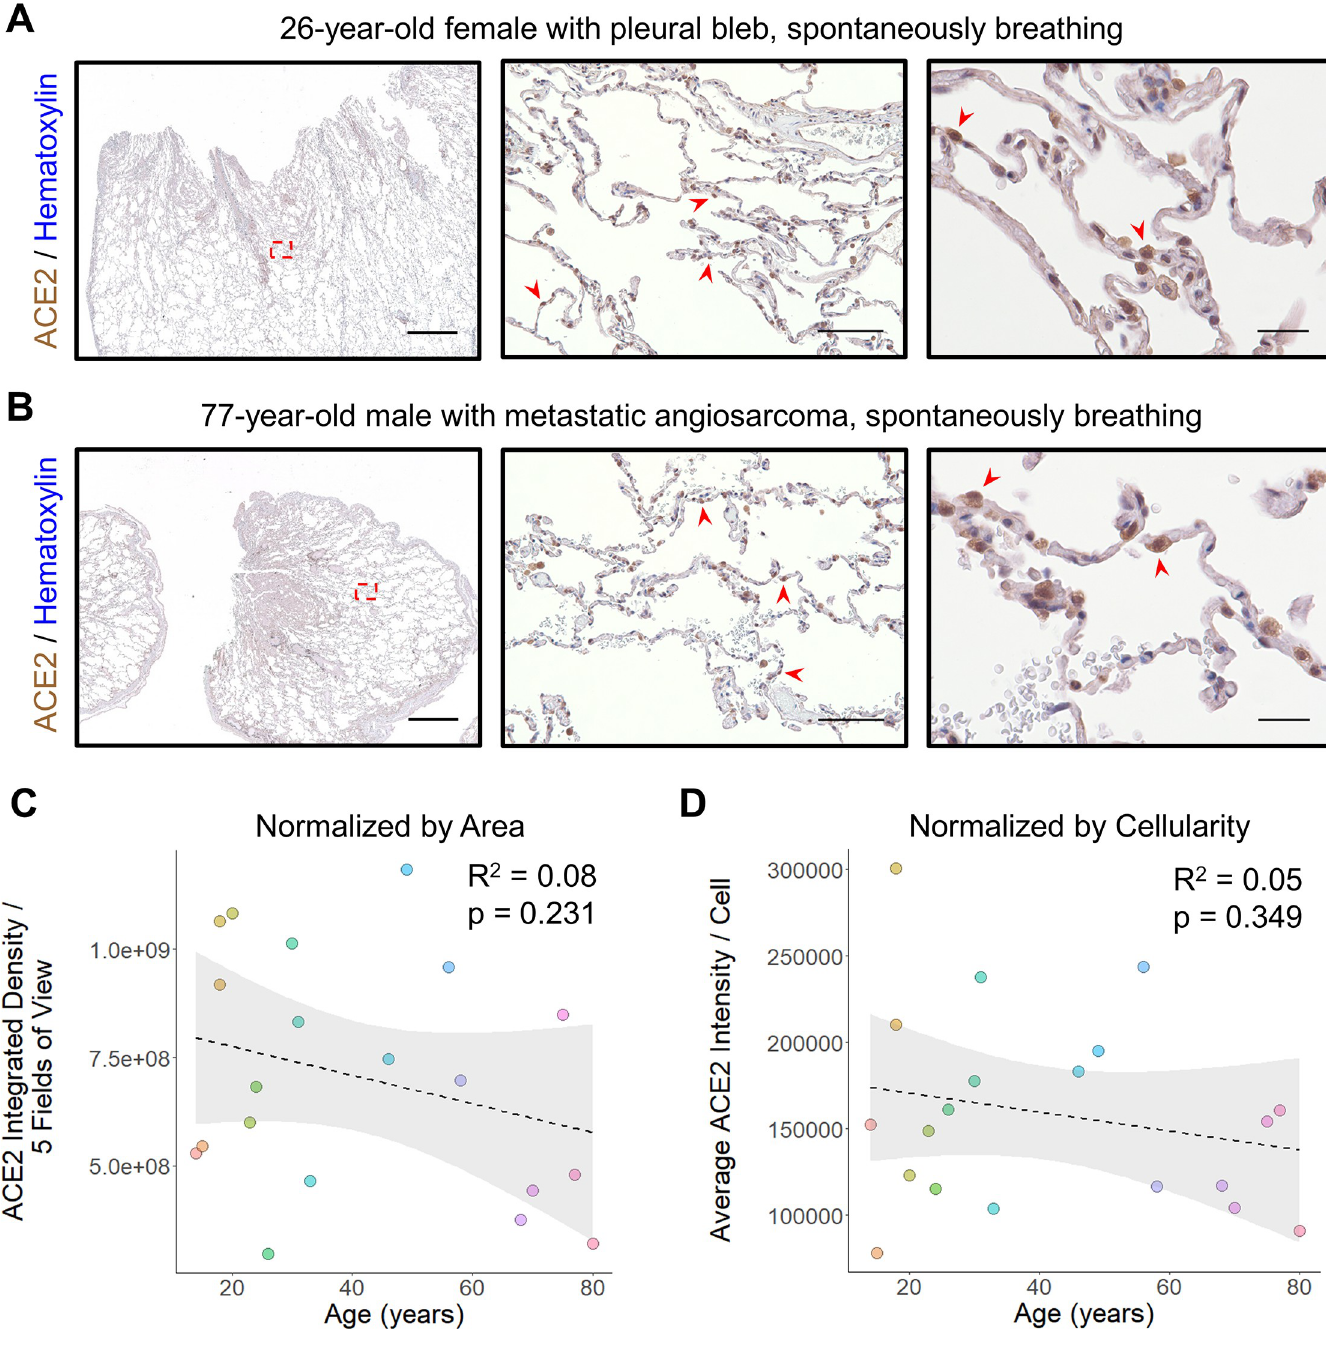
Fig 4. ACE2 protein expression does not change with age in non-ventilated patients. A) Representative images of lung stained for ACE2 from a 26-year-old female who underwent blebectomy for a spontaneous pneumothorax are shown using a 1x objective (left, scale bar 3mm) with the region outlined by the red dashed box magnified at low power (middle, scale bar 200 μ m) and a second field at high power (right, scale bar 50 μ m). The normal alveolated lung parenchyma reveals AT2 cells which are positive for ACE2 (red arrowheads) scattered among largely ACE2 low type I pneumocytes. B) Representative images of lung stained for ACE2 from a 77-year-old man undergoing wedge resection for suspected metastatic angiosarcoma are shown using a 1x objective (left, scale bar 3mm) with the region outlined by the red dashed box magnified at low power (middle, scale bar 200 μ m) and a second field at high power (right, scale bar 50 μ m). Histologic findings in the normal alveolated parenchyma adjacent to the lesion were similar to those found in (A) with strong ACE2 staining in scattered AT2 cells (red arrowheads) and occasional alveolar macrophages. C) Quantitative IHC for ACE2 was carried out on samples from non-ventilated patients (n = 20 patients). Total ACE2 expression from 5 low power fields is plotted relative to the patient’s age at the time of specimen collection. A linear fit to the data is indicated by the dashed line with the 95% confidence interval highlighted in grey. D) The same specimens quantitated in (C) were normalized by cellularity and the average ACE2 expression per cell is plotted along with a linear fit to the data and its 95% confidence interval. Sections were stained for ACE2 using DAB and counterstained with hematoxylin.